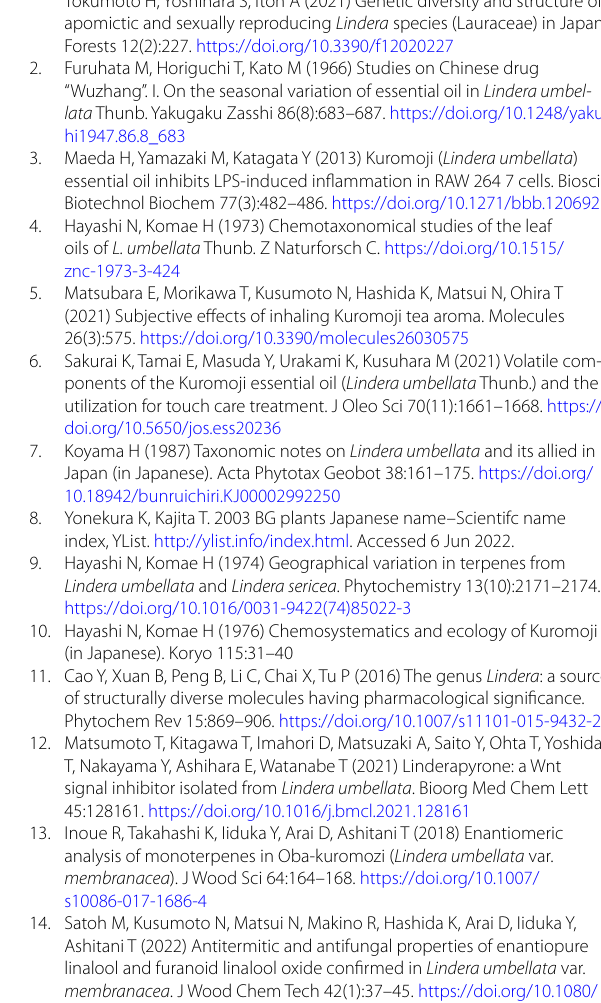
a CV ( SD) of the inter-individual variations calculated using the CV of each ± measured content (%/dw) over three seasons (June, August, and October) b CV ( SD) of the intra-individual variations calculated using the CV of each ± measured component (%/dw) in 15 individuals (A1–5, B1–5, and C1–C5). Components with a maximum content of < 0.1%/dw in each plant part are hyphenated